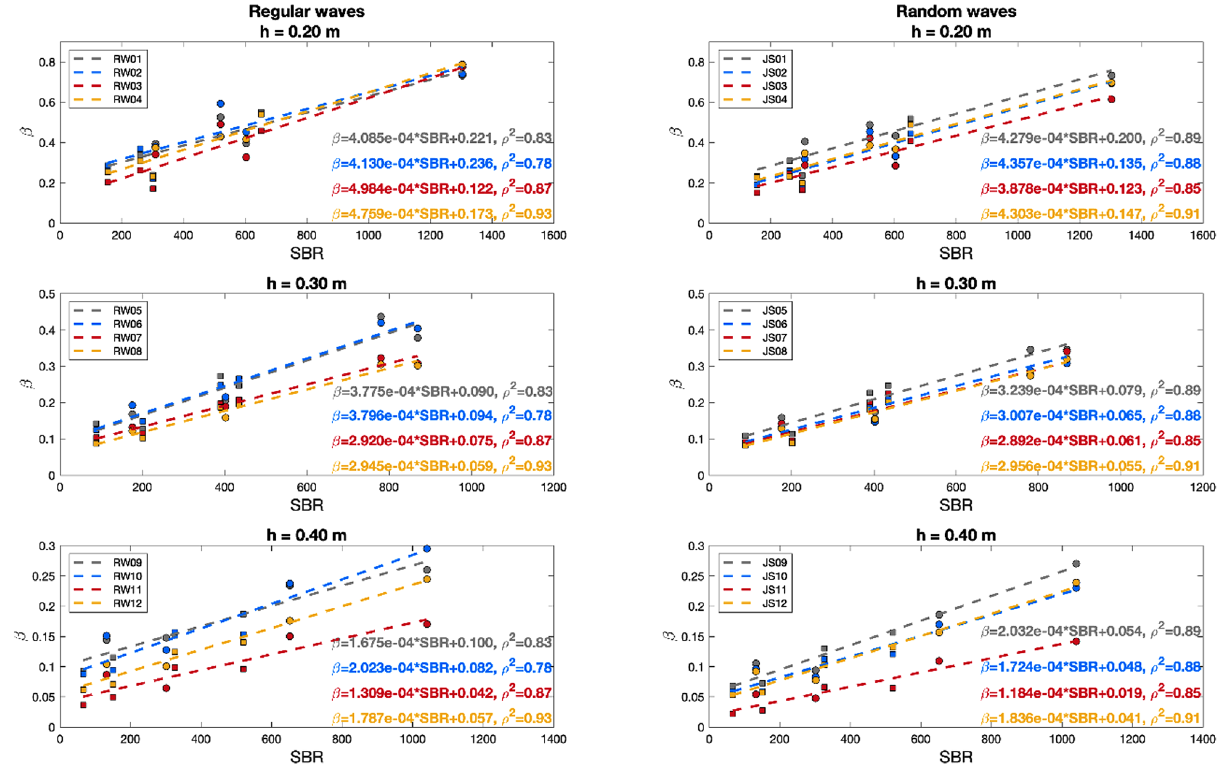
Figure 4. Wave damping coefficient, β , as a function of the standing biomass ratio, SBR , under all regular (left panels) and random (right panels) wave conditions. Each panel shows the wave trains assessed at each water depth, h = 0.20, 0.30 and 0.40 m. The results for the 100% density case are marked with circles and those for the 50% density case are marked with squares. The linear fitting results obtained under each wave condition are also